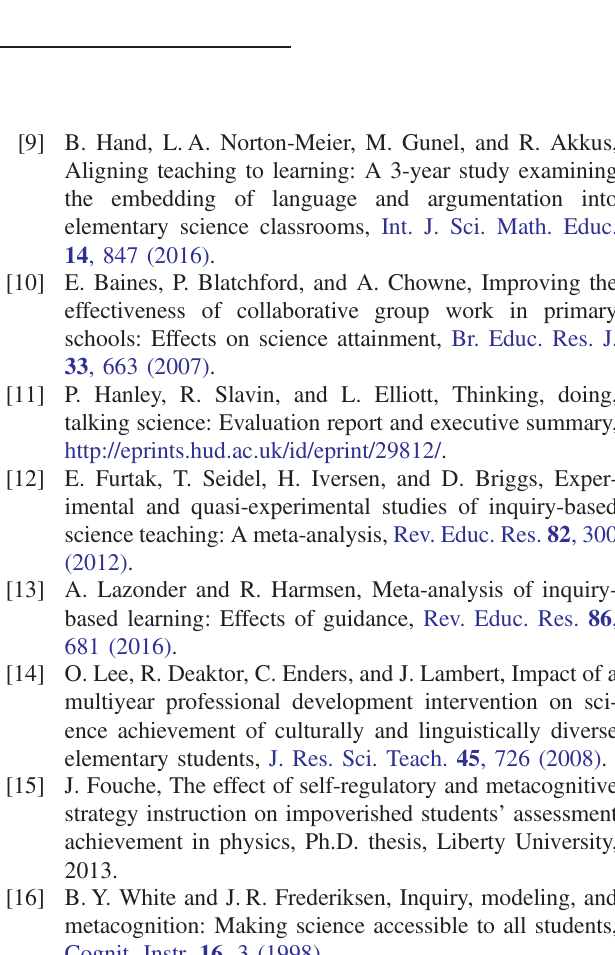
The brick slides at 1 . 2 m s − 1 along the table. Ignor- ing air resistance, what horizontal distance has the brick travelled between the edge of the table and landing point on the